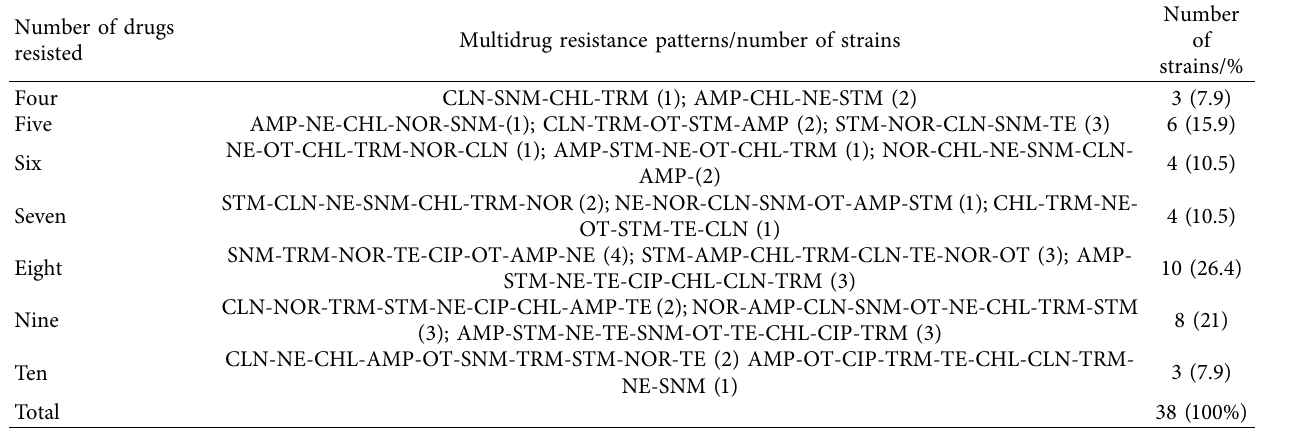
Table 6: Multidrug resistance of pathogenic Escherichia coli